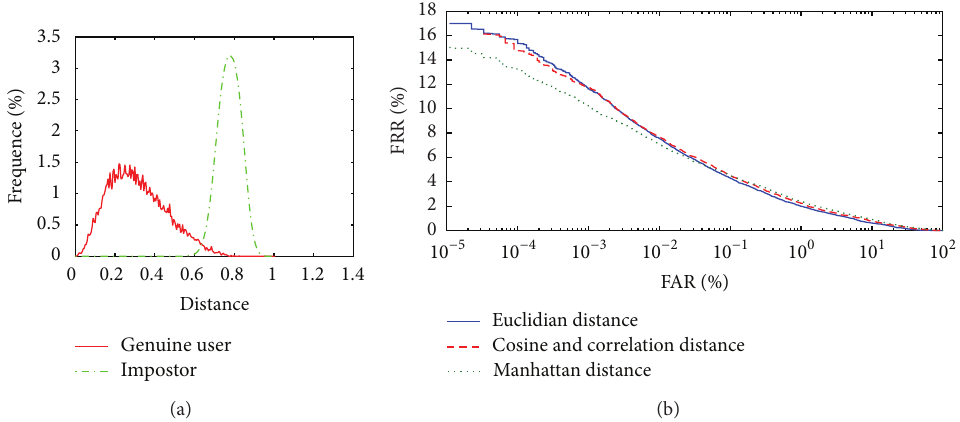
Figure 9: (a) Distribution of the genuine user and impostor without LPP using Euclidian classifier. (b) ROC curve without LPP to different classifiers.